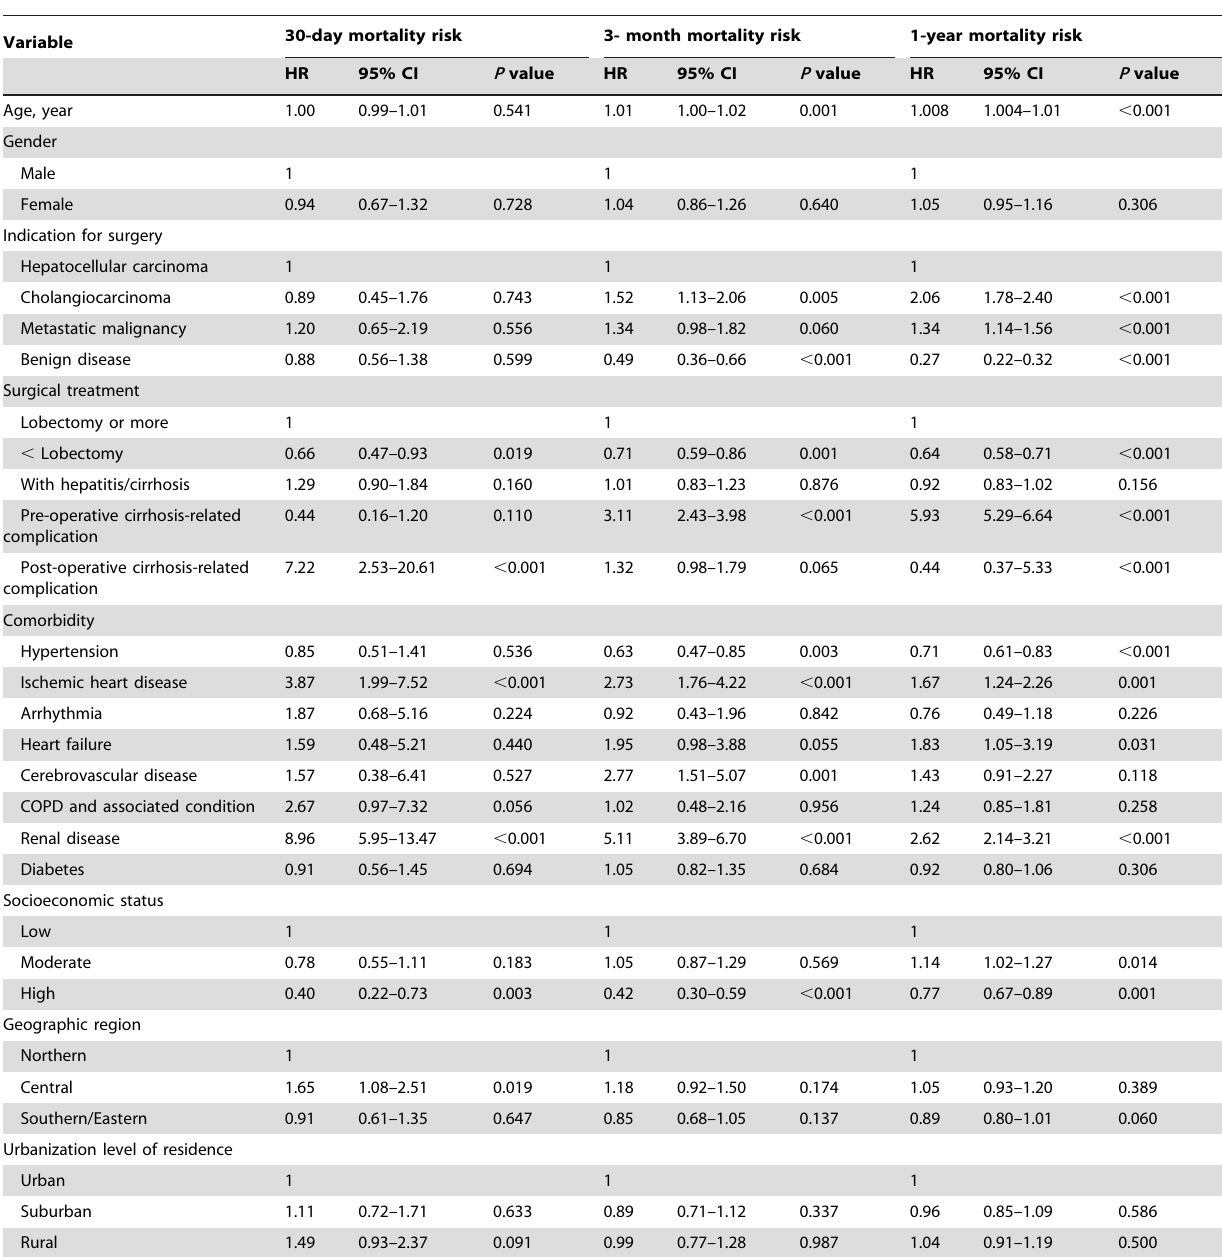
Table 3. The adjusted hazard ratios of patient demographic